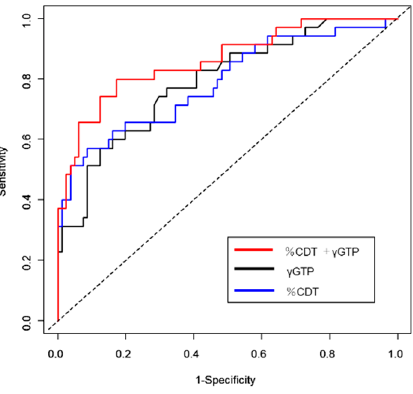
Figure 4. Receiver operating characteristic curves for % of carbohydrate-deficient transferrin and gammaglutamyl transferase alone and combined.